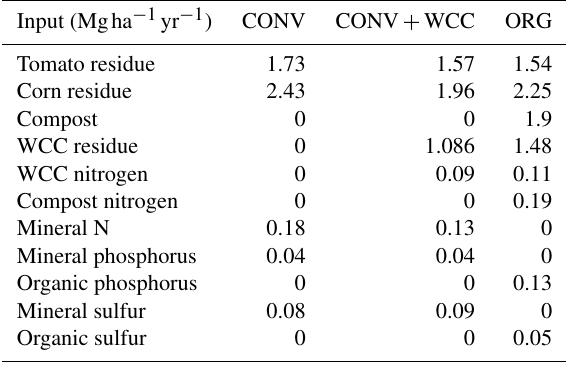
Table A4. Average annual inputs of carbon, nitrogen, phosphorus, and sulfur to ORG, CONV + WCC, and CONV plots between 1993 and 2018. Please note that sudangrass and Wheat C inputs were excluded from this table, as they were only grown for a limited amount of time.